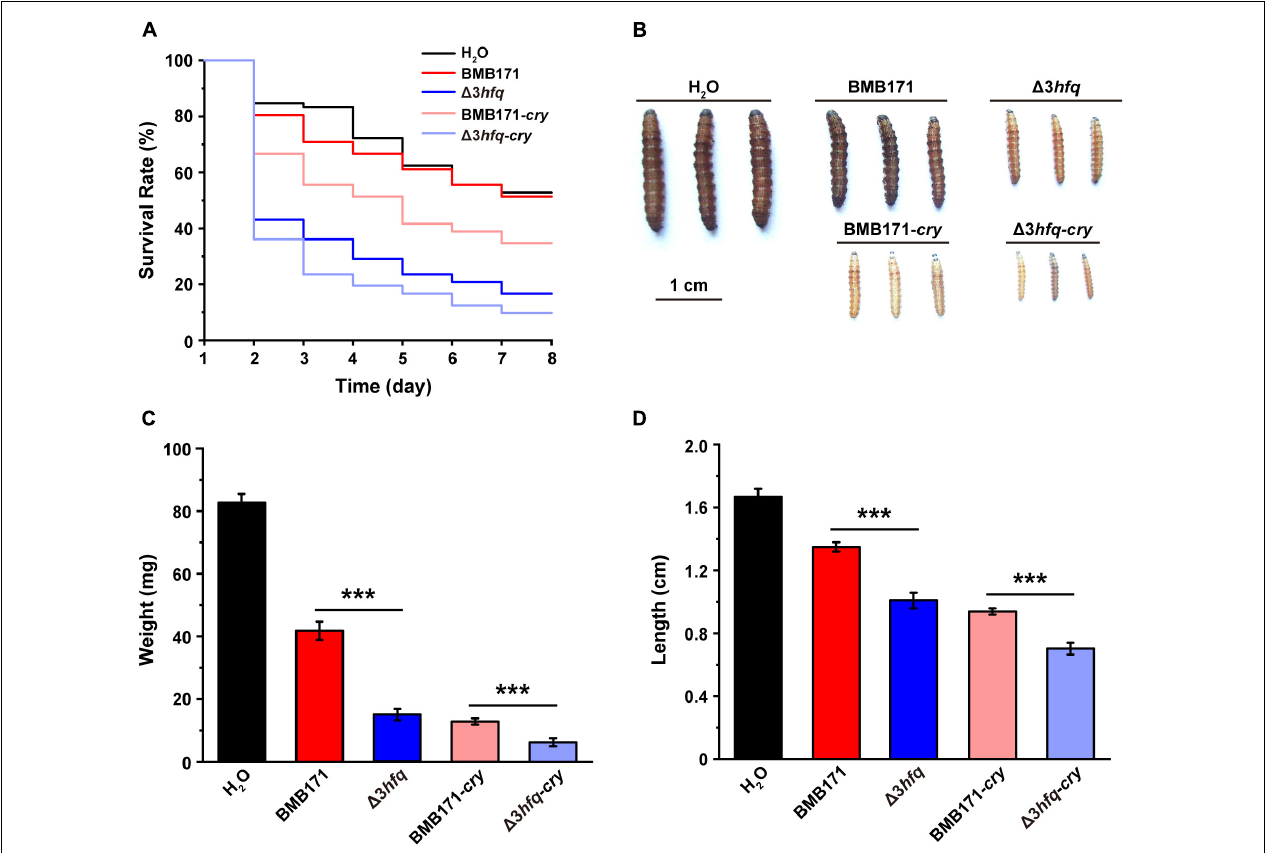
FIGURE 5 | Deletion of hfq results in enhanced insecticidal activity. (A) Survival rates of cotton bollworm larvae fed with different strains for 7 days. (B) Morphological characteristics of cotton bollworm larvae after 7 days of feeding. (C) Weights of cotton bollworm larvae after 7 days of feeding. (D) Lengths of cotton bollworm larvae after 7 days of feeding. The values are means ± SDs for triplicate assays. Significances of differences by Student’s t -test are indicated. *** p < 0.001; ** p < 0.01; * p <